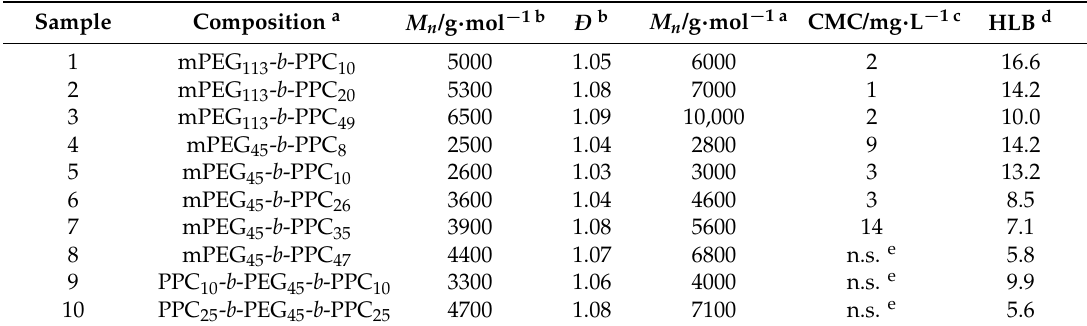
Table 1. Overview of all characterization data for all AB and ABA copolymers.